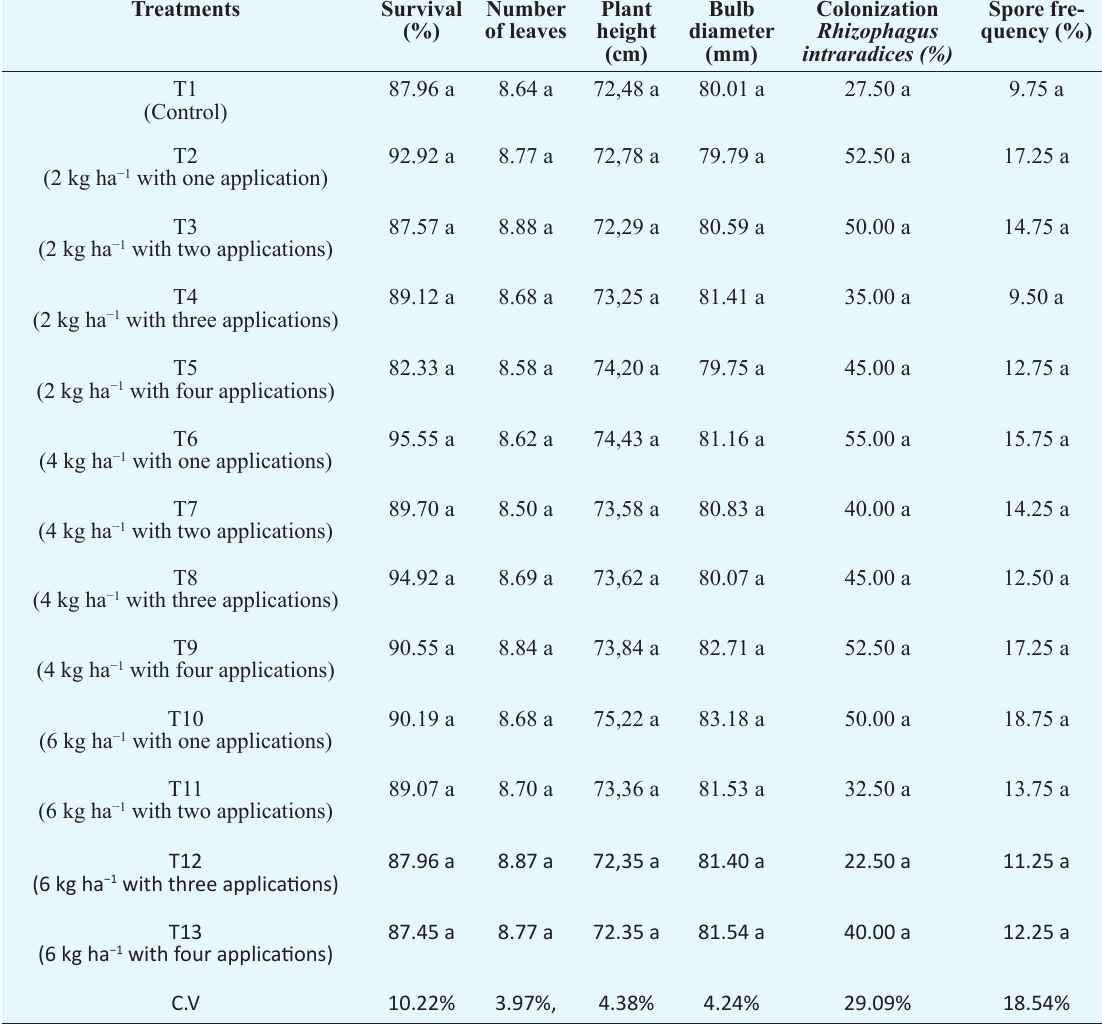
Table 3. Results of the variables evaluated and comparison test of means Duncan (α =